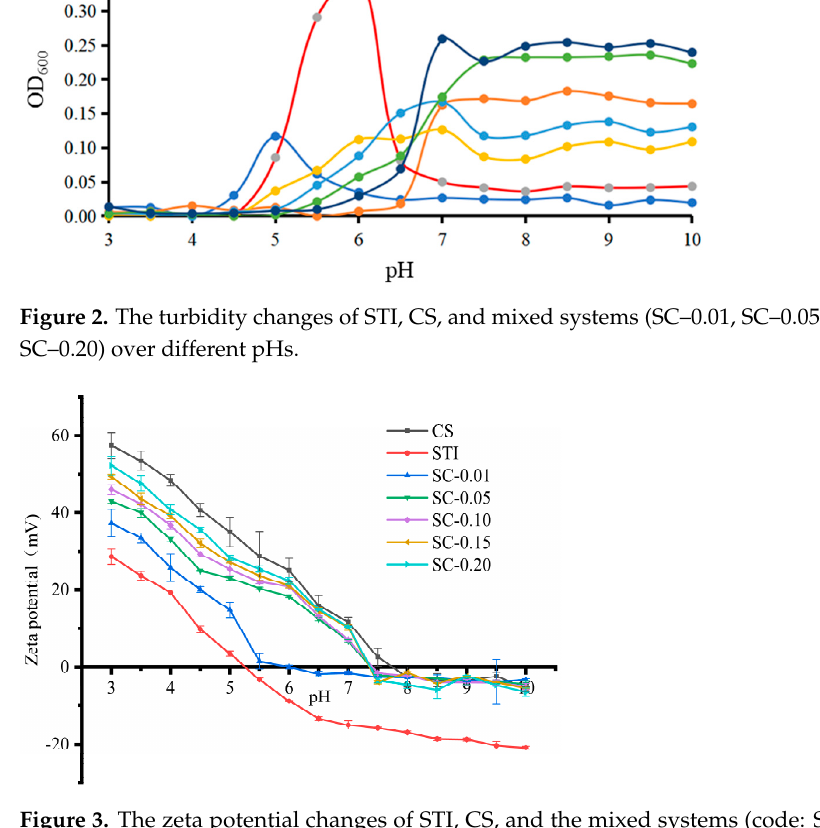
Figure 3. The zeta potential changes of STI, CS, and the mixed systems (code: SC − 0.01, SC − 0.05, SC − 0.10, SC − 0.15, SC − 0.20) over different